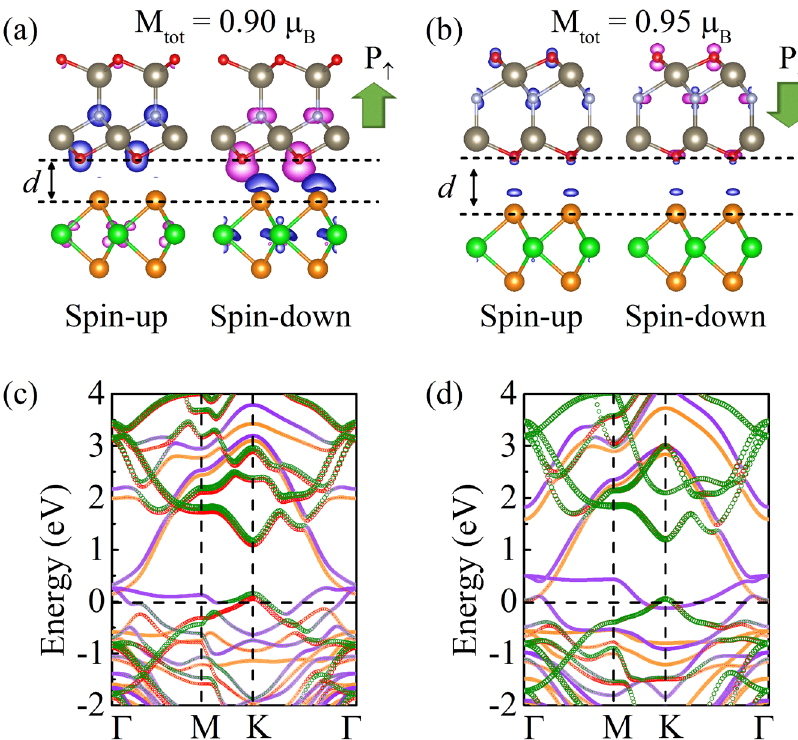
Fig. 4 A possible magnetoelectric effect in Tl 2 NO 2 /WTe 2 heterostructure. a , b The charge density differences in spin-up and spin-down channels for Tl 2 NO 2 /WTe 2 heterostructure with polarization directions pointing ( a ) upward and ( b ) downward. Red, wathet, gray, orange, and green spheres denote O, N, Tl, Te, and W atoms, respectively. The green arrows denote the direction of polarizations. The interlayer distance is donated by d . ( c , d ) The spin-resolved band structure of the Tl 2 NO 2 /WTe 2 heterostructure with polarization directions pointing ( c ) upward and ( d ) downward. The orange and violet lines indicate the spin-up and spin-down bands contributed by Tl 2 NO 2 monolayer, respectively. The sizes of the red and green dots represent the weights of spin-up and spin-down states contributed by the WTe 2 monolayer,